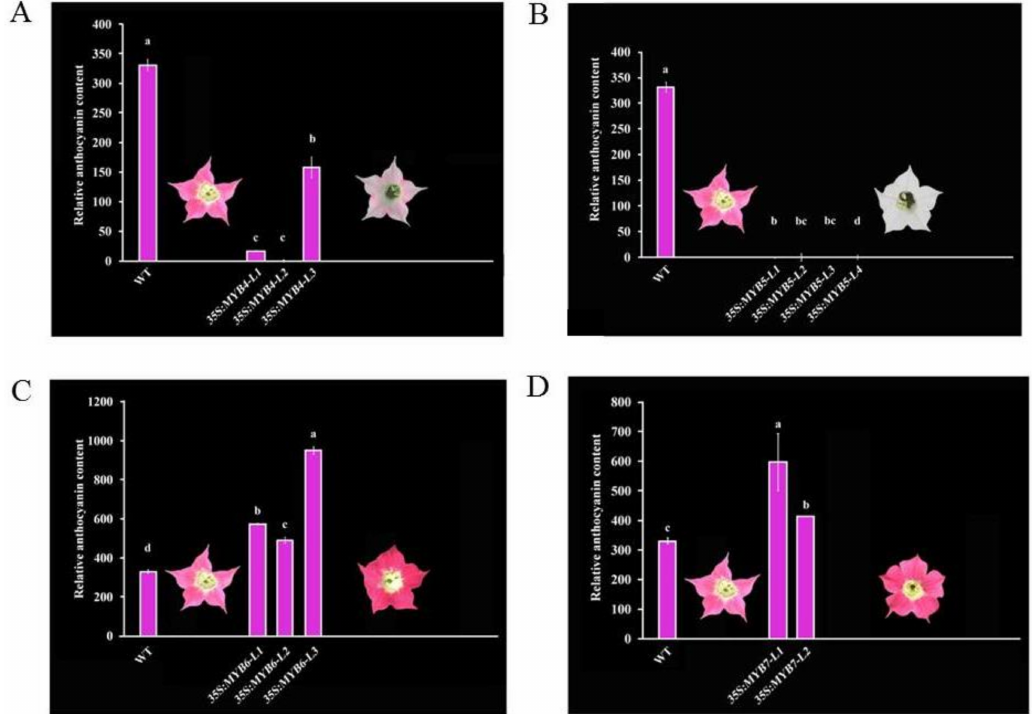
Figure3. Pigmentalandphenotypicchangesinthe( A ) 35S:CmMYB4, ( B ) 35S:CmMYB5, ( C ) 35S:CmMYB6 , and ( D ) 35S:CmMYB7 tobacco lines. The results are presented as the mean ± SD of three replicates. Di ff erent letters represent significant di ff erences at p < 0.05 between di ff erent samples. L1, L2, L3, and L4 indicate independent transgenic tobacco lines obtained in the present study. WT, wild